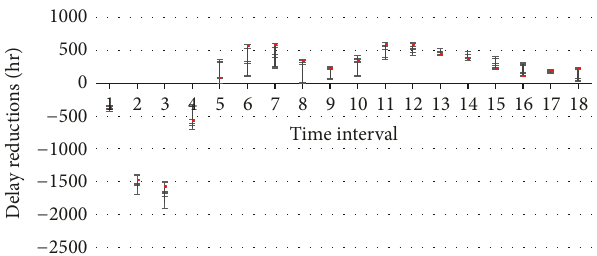
Figure 4: Total delay reductions between no-CVs and 30 percent CVs.